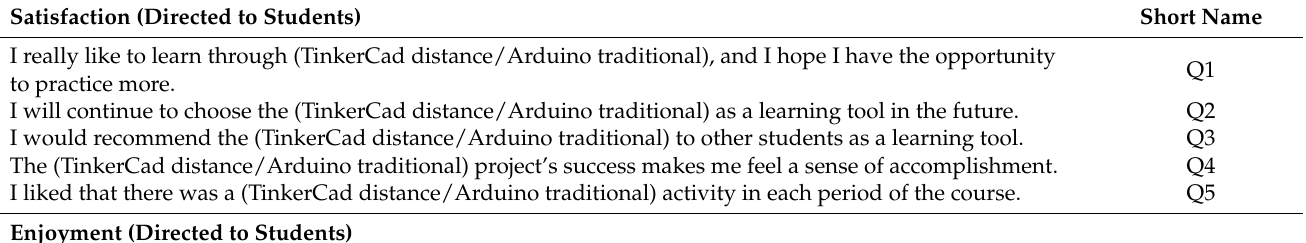
Table 2. The anonymous questionnaire directed to the students to receive feedback on satisfaction, enjoyment and motivation dimensions and to tutors to receive feedback on the students’ programming outcomes. Satisfaction (Directed to